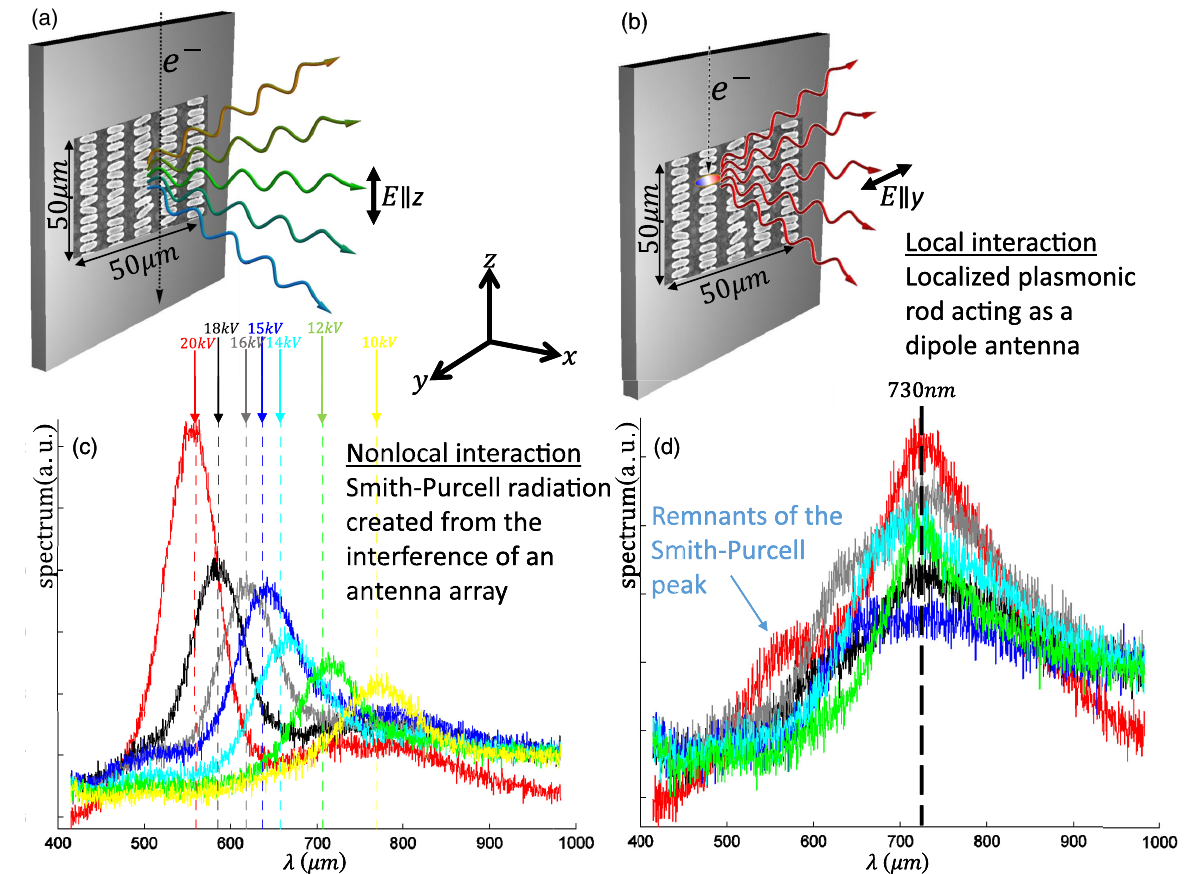
FIG. 4. Collective and resonant effects in the interaction of free electrons with a disordered plasmonic structure. (a) Illustration of the Smith-Purcell emission from the 2D plasmonic crystal with strong disorder. (b) Illustration of the emission from the localized plasmonic resonance of a single silver rod. In both (a) and (b), the electron beam is plotted with a dashed black line, and the emitted light is drawn as wiggly arrows. The semiperiodic structure itself is the SEM image of the real pattern. (c) Measuring the spectra for different kinetic energies with a polarizer that transmits light polarized along the z axis. This shows a very good match to conventional Smith-Purcell theory [Eq. (1)], marked by dashed lines in the color corresponding to the same kinetic energies. (d) Measuring the spectrum with a polarizer that transmits light polarized along the y axis. This shows a single plasmonic resonance at 730 nm, agreeing with simulations (see Fig. 6). Note that small features from the spectral peaks of (c) can be seen in (d) and vice versa. This is explained by the conventional Smith-Purcell radiation not being entirely z polarized in this structure, in addition to imperfections in the polarization filtering. For comparison of the scales, the red peak in (c) is 2.4 times more intense than the red peak in